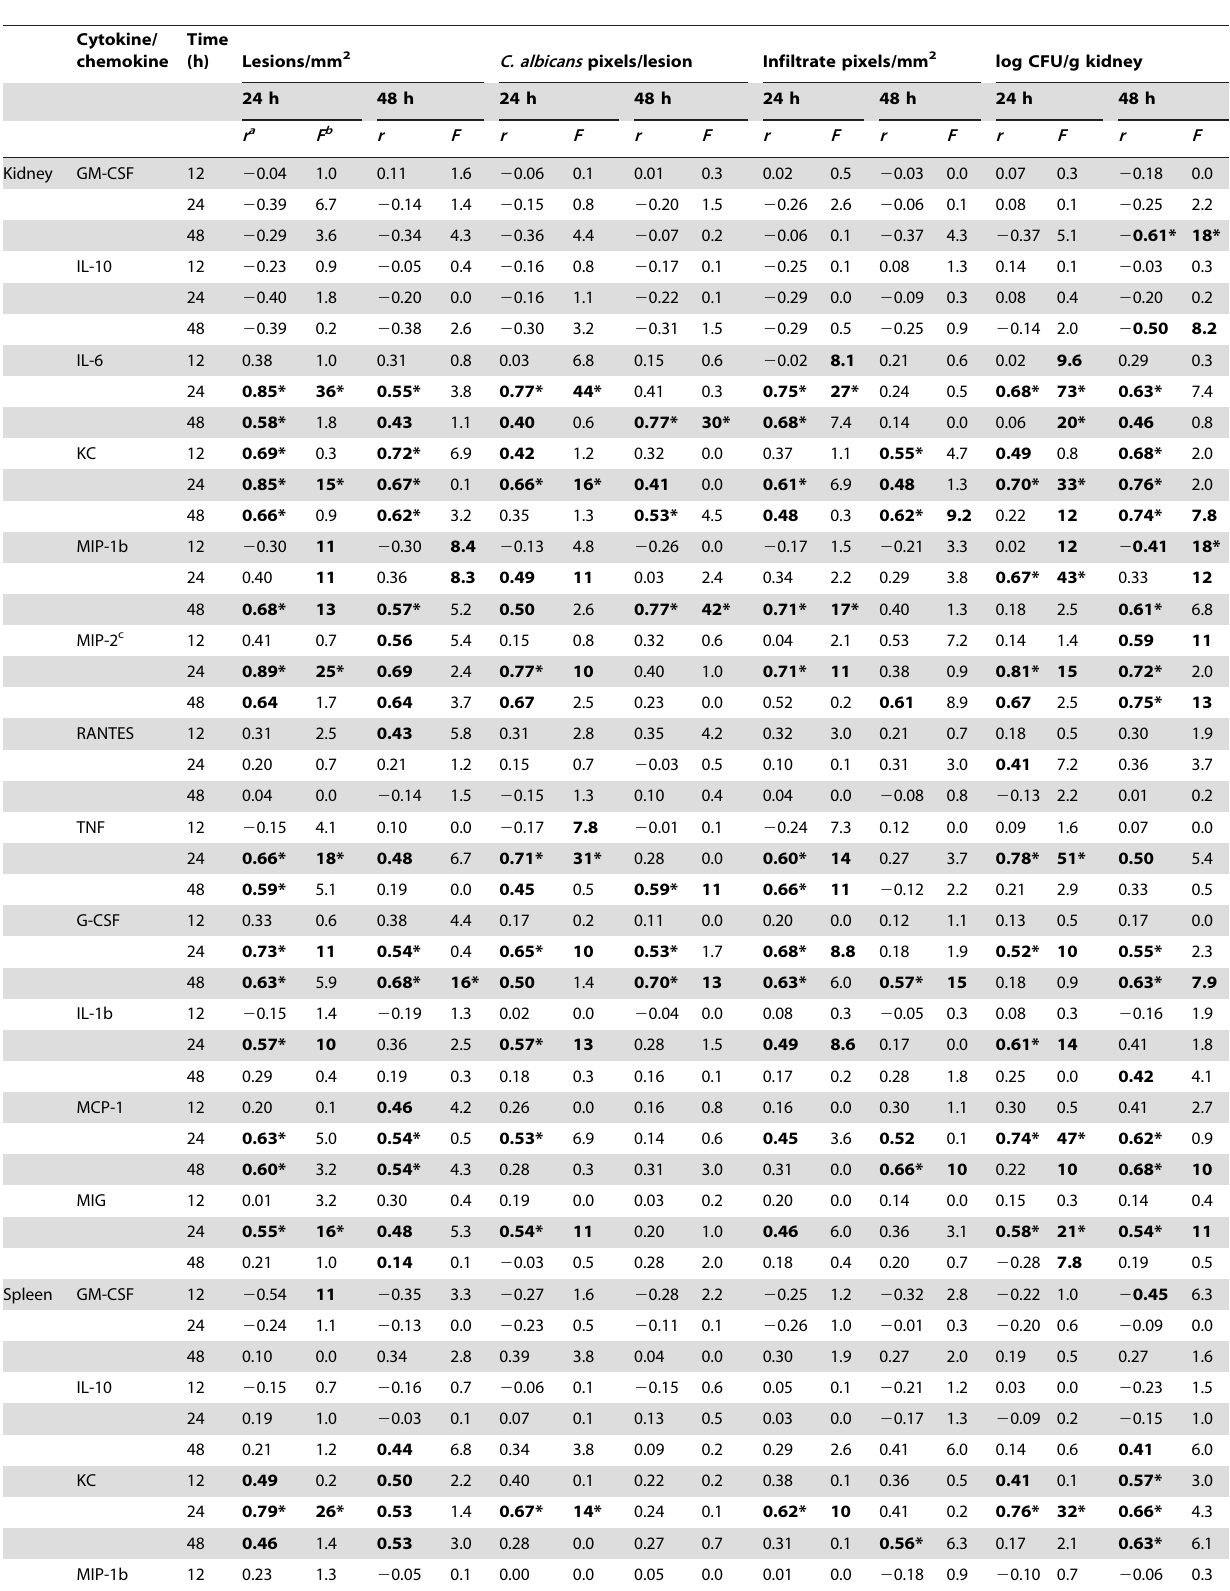
Table 3. Statistical associations between cytokine and chemokine measurements in kidney and spleen samples, measured at 12, 24 and 48 h, and kidney lesion parameters measured at 24 and 48 h in mice infected with 11 C. albicans strains. Cytokine/ Time chemokine